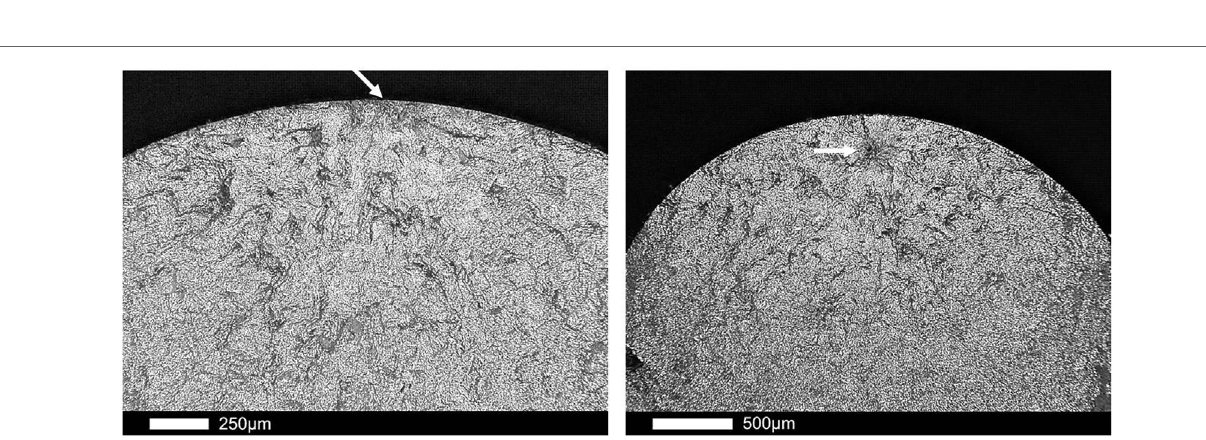
FigUre 4 | high cycle fatigue properties of hot-isostatic-pressed Ti–6al–4V under tension–tension and tension–compression loading .